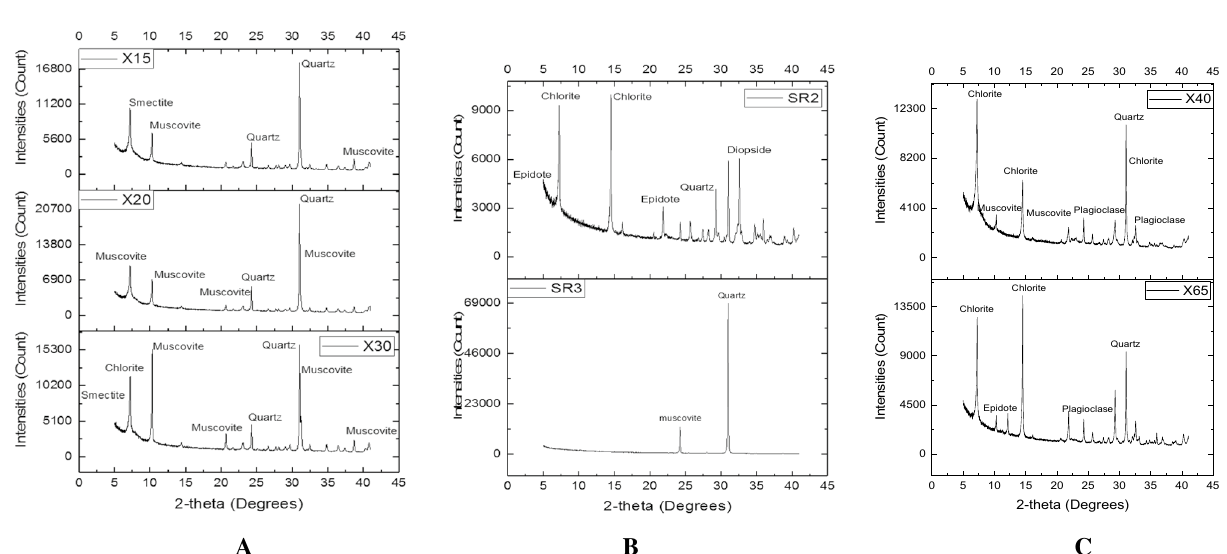
Figure 7. XRD plot showing major minerals in borehole 1 at X15, X20 & X30 ( A ) and surface soil SR2 & SR3 ( B ) borehole 1 at X40 and